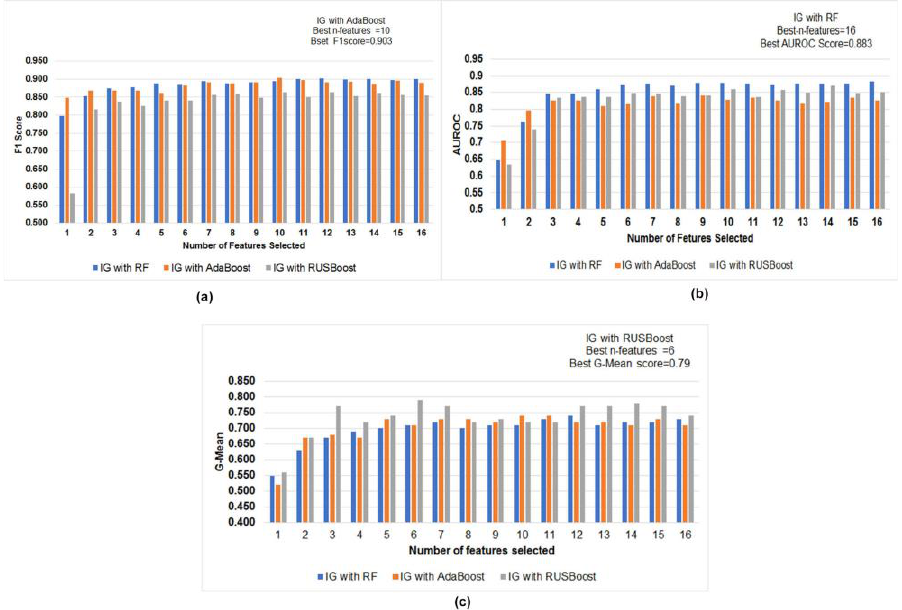
Figure 2. ( a – c ): Comparative evaluation of performance measures ( a ) F1-score ( b ) AUROC ( c ) G-mean in models built using a different subset of features using information gain.